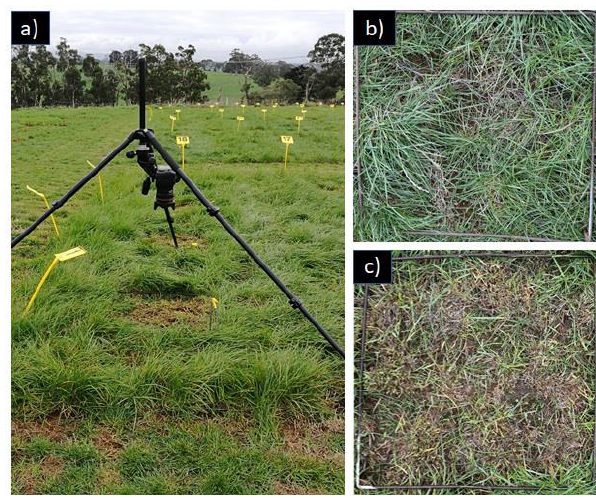
Figure 3. ( a ) Camera arrangement for RGB image acquisition at a sampling point, ( b ) preharvest RGB image of a sampling point ( c ) postharvest RGB image of the same sampling point.